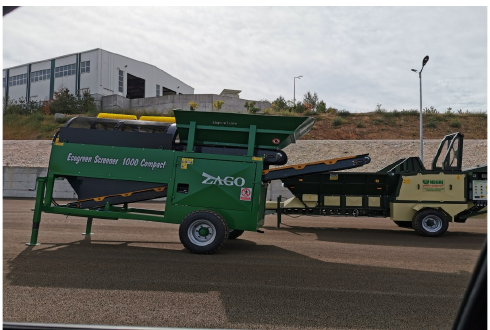
Figure 6. Autonomous drum sieve, Ecogreen Screener L1000, Zago.